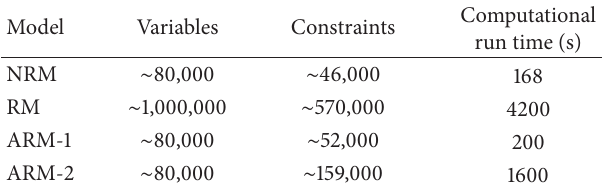
Table 2: Computational comparison of the four